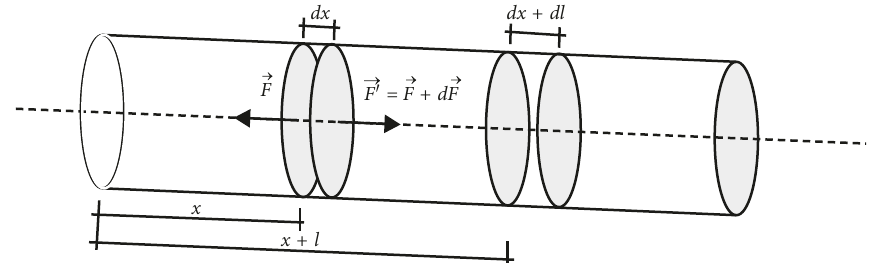
Figure 1: Propagation of vibration along a steel